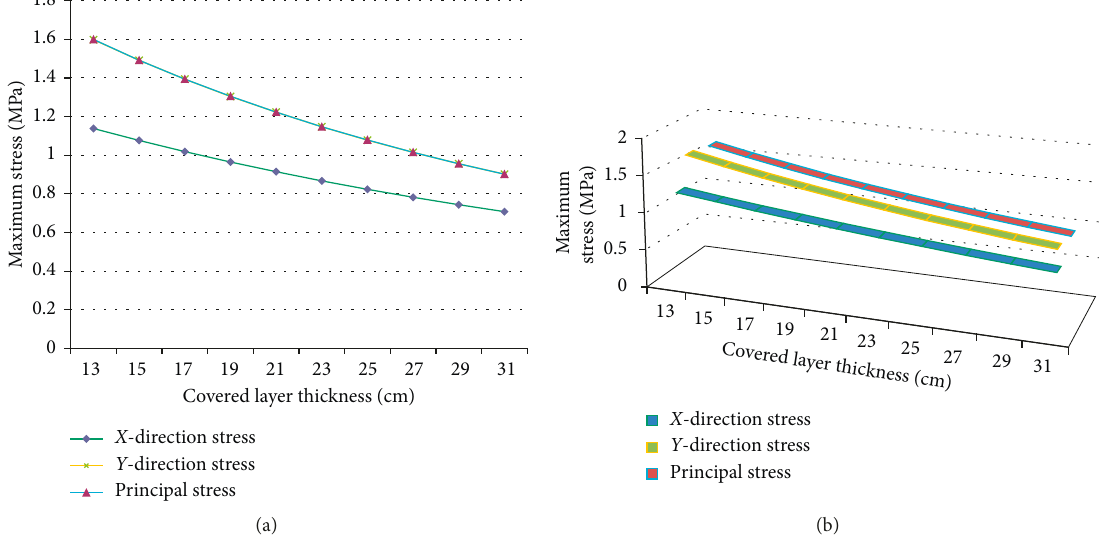
Figure 17: Variation of original surface layer stress with covered layer thickness: (a) two-dimensional broken-line graph; (b) three-di- mensional broken-line